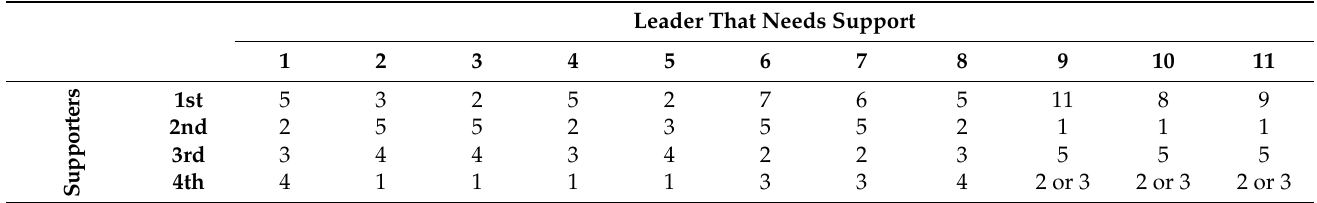
Table 5. Supporting leaders for every leader that needs help during the cooperative control. Leader That Needs